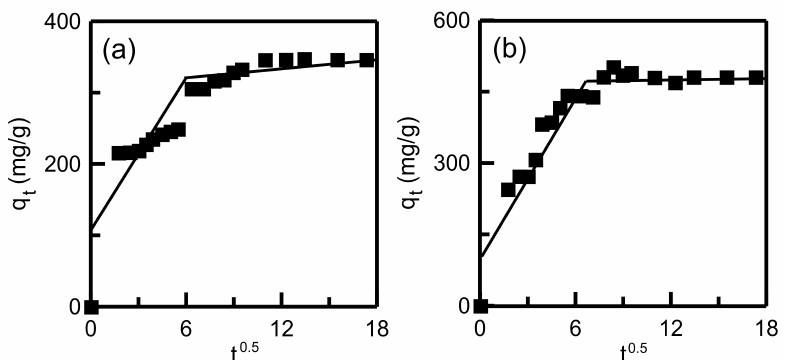
Figure 15. Intraparticle diffusion plot for dye adsorption onto adsorbents: ( a ) RH-SBA-15 and ( b )